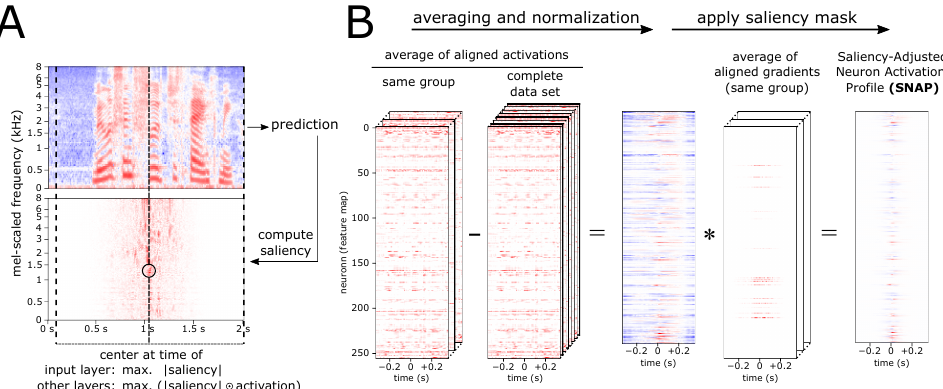
Figure 1. ( A ) Alignment procedure and ( B ) Saliency-Adjusted Neuron Activation Profile (SNAP) computation for a